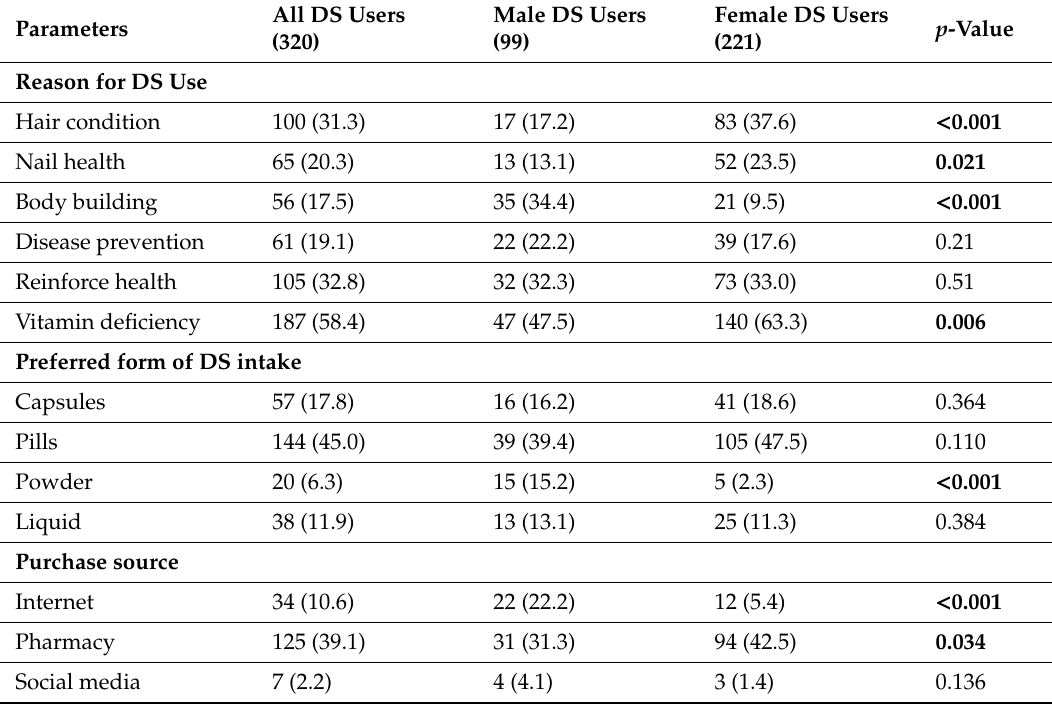
Table 5. Source, reason and form of DS use and intake among